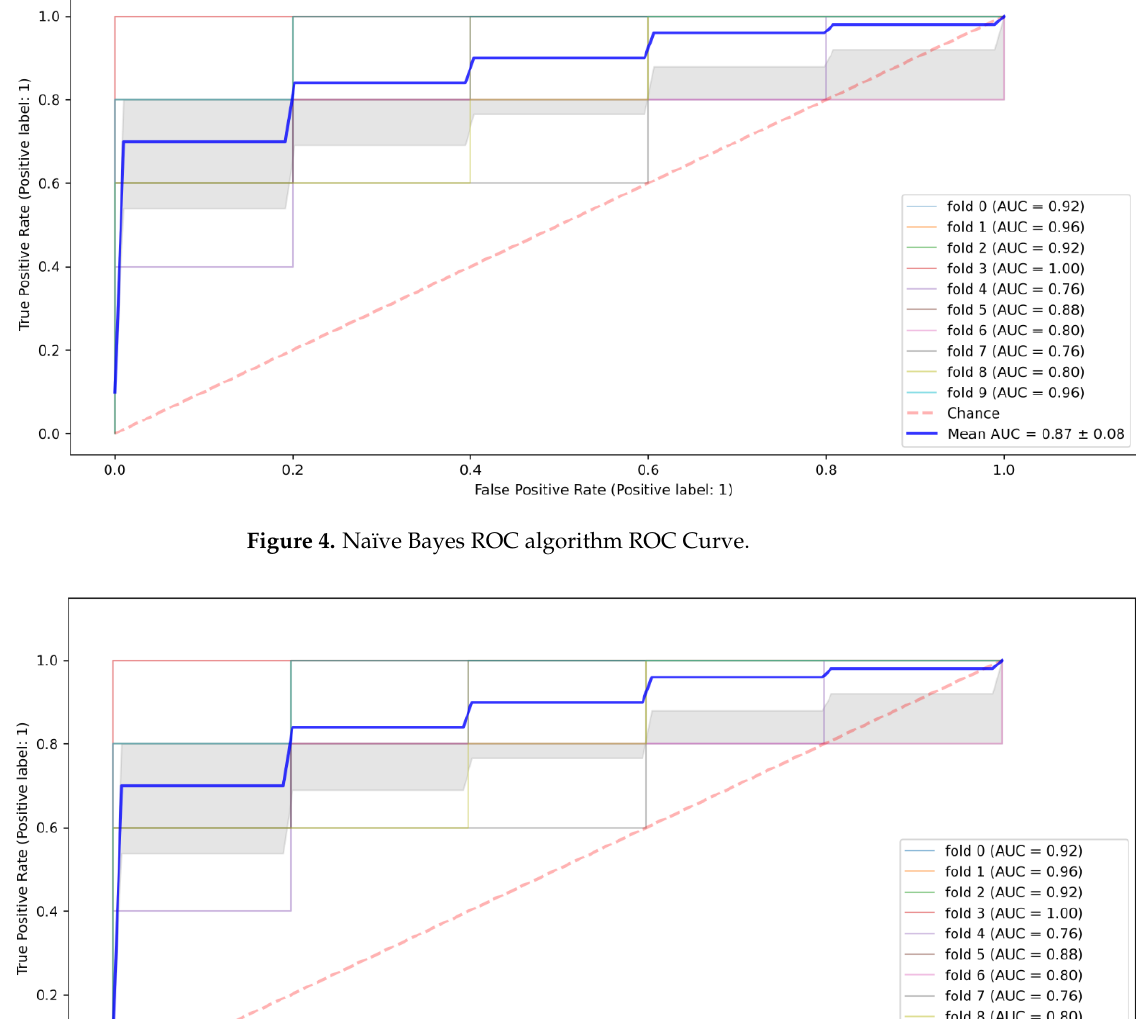
Figure 5. Support Vector Machine’s ROC Curve.